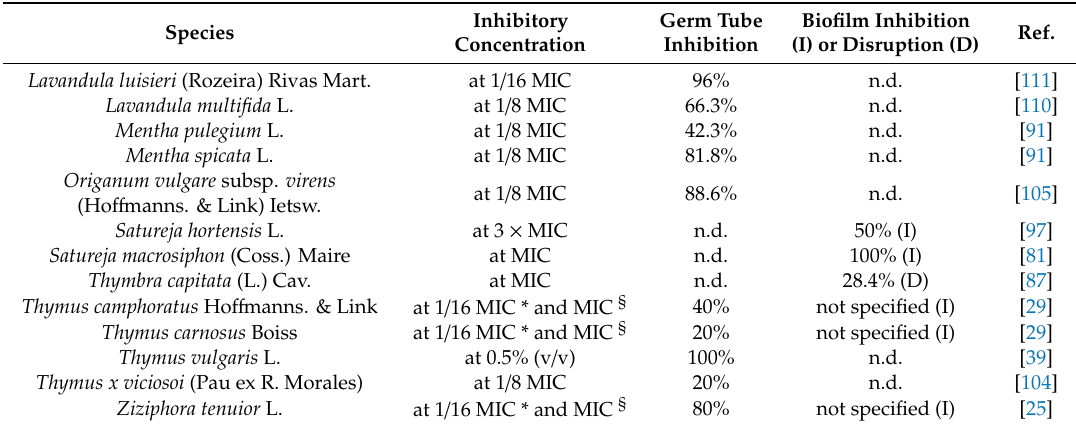
Table 3. Plant species producing EOs with anti-virulence activity against C. albicans reference strains. Inhibitory Germ Tube Biofilm Inhibition Ref. Species Concentration Inhibition (I) or Disruption (D) Lavandula luisieri (Rozeira) Rivas Mart. at 1 / 16 MIC 96% n.d. [111] Lavandula multifida L. at 1 / 8 MIC 66.3% n.d. [110] Mentha pulegium L. at 1 / 8 MIC 42.3% n.d. [91] Mentha spicata L. at 1 / 8 MIC 81.8% n.d. at 1 / 8 MIC 88.6% n.d. Satureja hortensis L. at 3 × MIC n.d. 50% (I) at MIC n.d. 100% (I) at MIC 28.4%